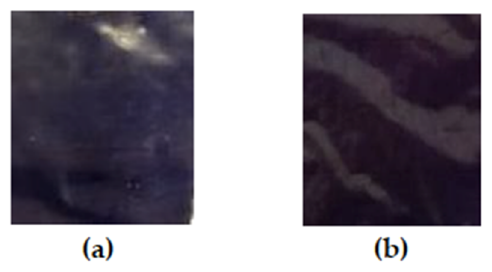
Figure 6. Films based on cellulose acetate incorporated with PDA (60 mg) and TEC (12.5%): ( a ) 30 min